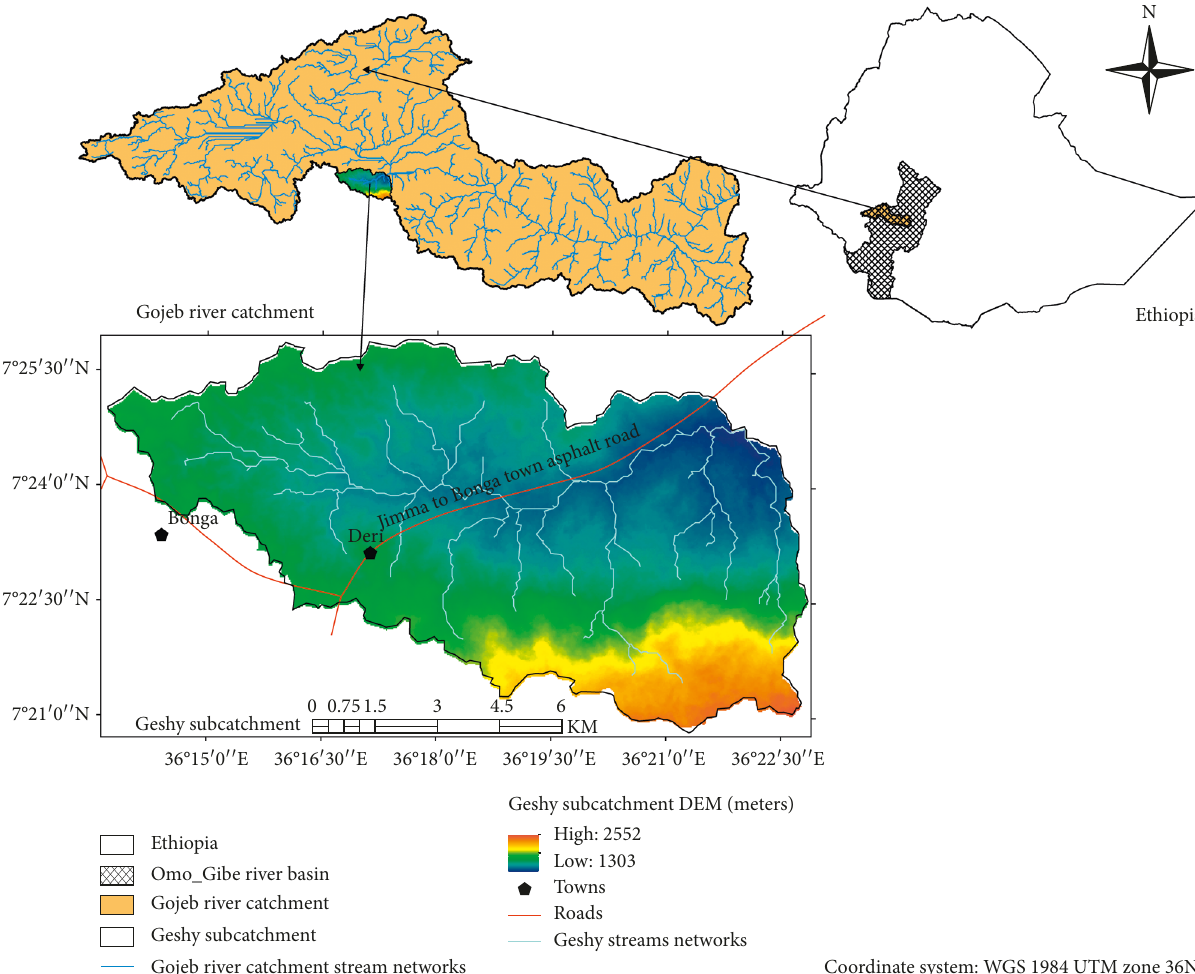
Figure 1: Study map of Geshy subcatchment, Gojeb River Catchment, Ethiopia.